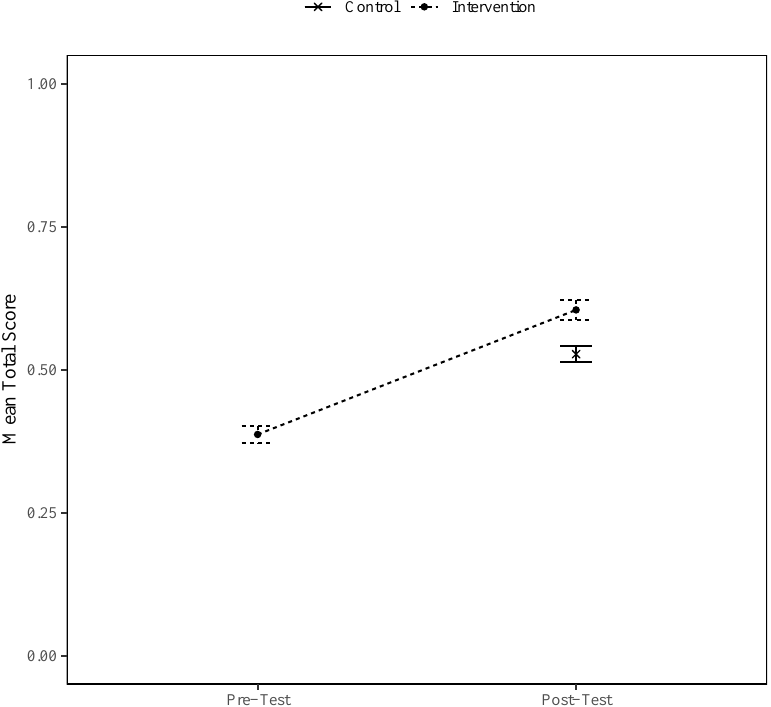
Figure 7. Mean total score of all items in pre- and post-test for the intervention group and mean total score of all items in post-test for the control group (error bars represent standard error of the